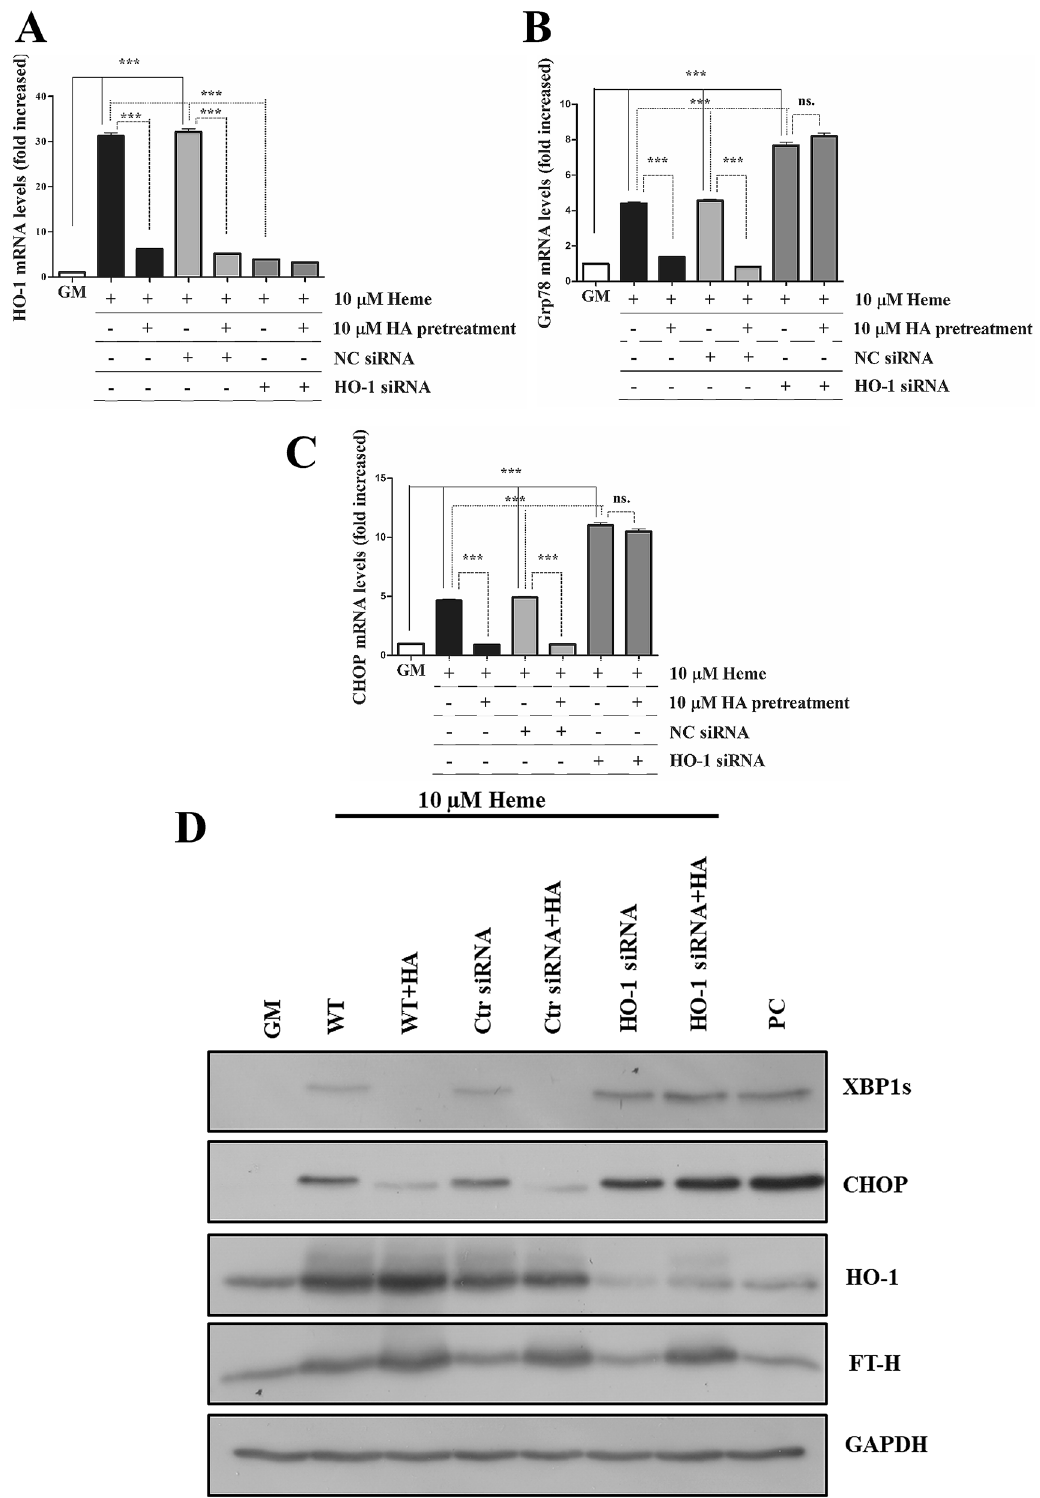
Figure 7. Lack of protection by heme arginate against HIER stress in HO-1-silenced cells. HO-1 expression was knocked down by siRNA antiHO-1 as described above, then ECs were pre-incubated with HA (10 µM) in CM199 medium supplemented with 10% FCS and antibiotics for 16 h. Then, ECs were washed and exposed to heme (10 µM) for 2 h in CM199 medium without FCS and antibiotics. ECs were then washed with HBSS+ and further incubated with CM199 supplemented with 10% FCS and antibiotics for 3 h. ( A ) Relative expression of HO-1, ( B ) Grp78, ( C ) CHOP were analyzed and normalized to GAPDH. ( D ) Representative immunoblot showing XBP1s, CHOP, HO-1, and FT-H expression. GM growth medium, NC non-coding siRNA, HA heme arginate, PC positive control. Relative mRNA expressions were normalized to GAPDH. GAPDH was used as a loading control in immunoblots. Immunoblots are cropped from different parts of the same gel. Uncropped immunoblots are presented in the Supplementary information. Data are shown as mean ± SEM of three independent experiments. Statistical analysis was performed by one-way ANOVA test followed by Bonferroni correction. A value of p < 0.05 was considered significant. *** p <